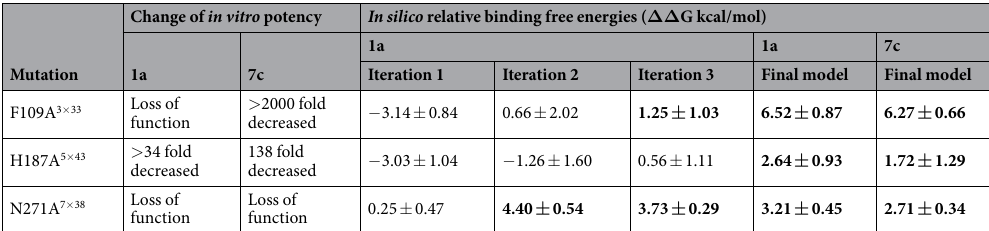
Table 2. GPR139 in silico mutant effects of 1a and 7c binding. Iterative procedure of model optimization using molecular dynamics and the relative binding free energies obtained by free energy perturbation (FEP) calculations in comparison with in vitro potency as a scoring function. The FEP relative binding free energies that are in agreement with in vitro data are shown in bold.